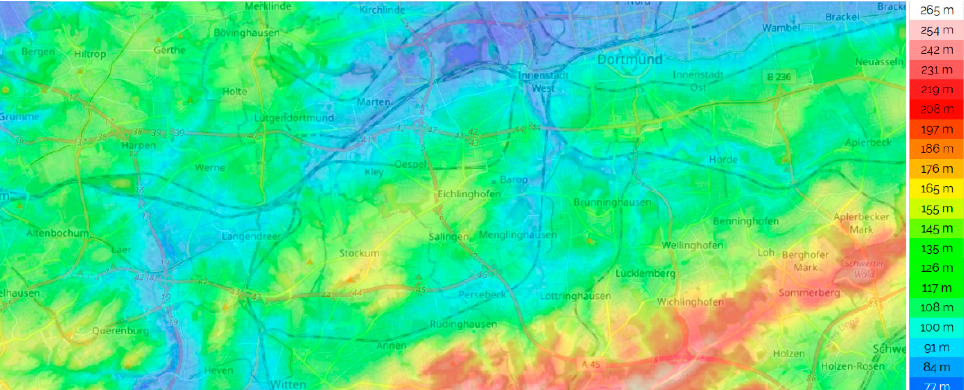
Figure 3. Topography around the city of Dortmund (Germany) displayed in vector format [18]. One form of raster data are image data, which for instance could be aerial or satellite images. Those are not based on ground measurements but instead they represent measurements of the reflected electromagnetic energy from the land surface. Sensors on flying platforms such as air planes, helicopters, drones or unmanned aerial systems (UAS), and satellites capture the reflected electromagnetic energy in different individual wavelengths and store the images on board. For further information on earth observation or so-called remote sensing, refer to [19–21]. An example of earth observation data is given in Figure 4, showing a false-color representation of parts of the city of Dortmund (Germany) in a cost-free Sentinel-2 satellite image with 10-m spatial resolution.